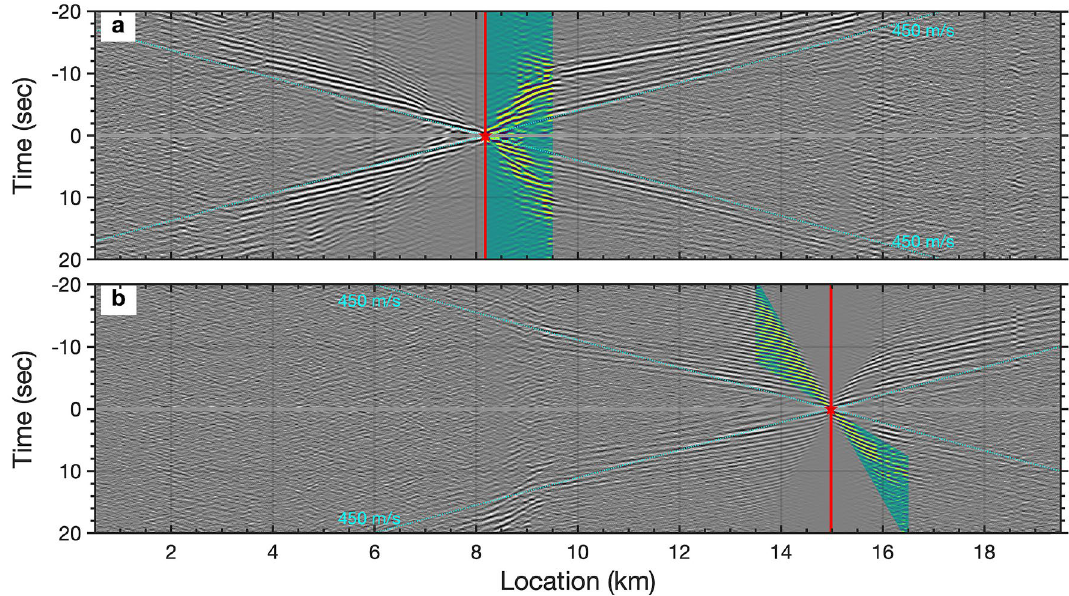
Figure 3. Scholte waves retrieved from oceanic microseism noise along the 20 km cable. ( a , b ) show empirical Green’s function gathers with virtual sources located at 8.2 km and 15 km, respectively. The red stars indicate the virtual sources. The cyan dashed lines indicate the approximate velocity of the Scholte wave. Backscattered Scholte waves are visible near the 9 km location of ( a ). The coherent signals on ( b ) appear to have a higher frequency which is consistent with the increasing spectrum on